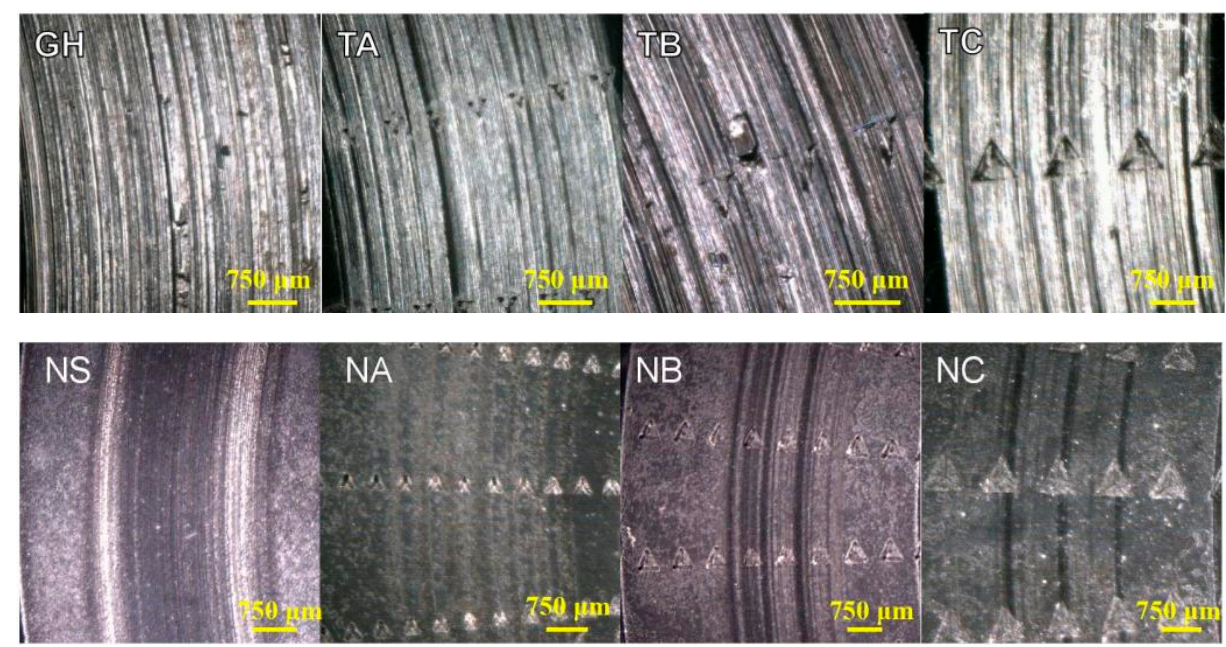
Figure 11. Experimental wear morphology of each group under optical microscope.